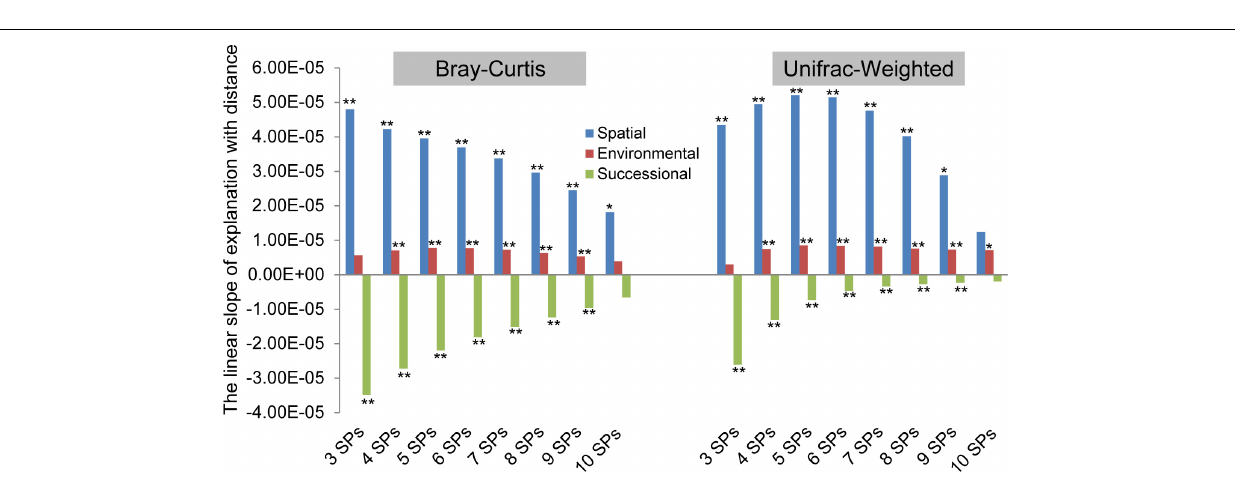
FIGURE 3 | The driving forces of spatial, environmental, and successional factors on archaeal community differences varied with the number of species pools (SPs). The permutational multivariate analysis of variance (permutation = 999) was used to calculate the explanations ( R 2 ) of successional stages (i.e., successional factor), geographical locations (i.e., spatial factor), and each of the environmental variables (i.e., environmental factor) for each combined meta-community variation based Bray–Curtis and UniFrac-Weighted dissimilarity. The number of sample plots contained in the combined community was considered the number of SPs. The slope was calculated by linear regression (* < 0.05, ** < 0.01) between the explanations ( R 2 ) and distance geographic distance (km), which was used to indicate the driving force of the three factors, affecting the biogeographic